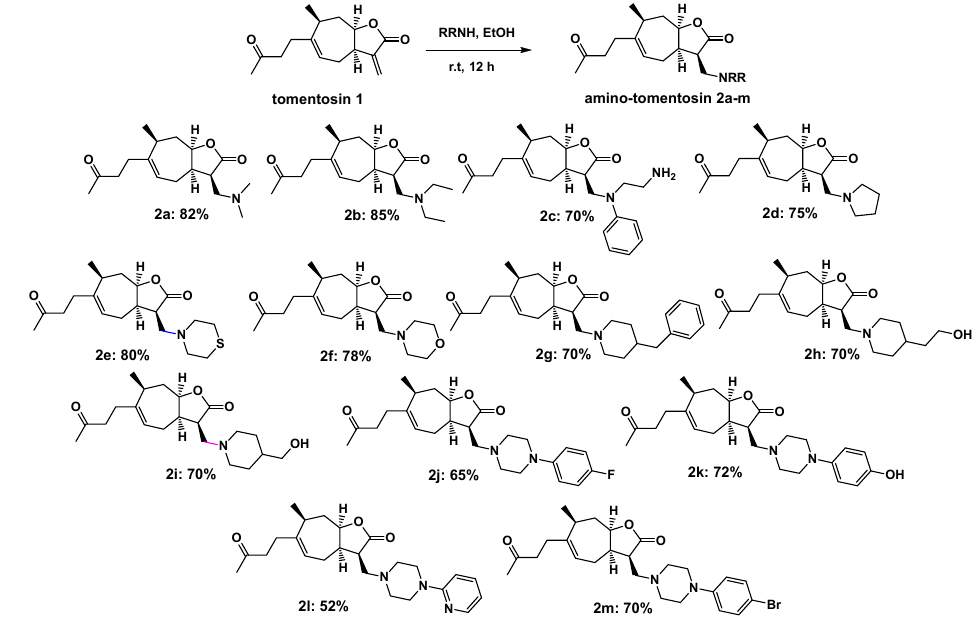
Scheme 1. Synthesis of various